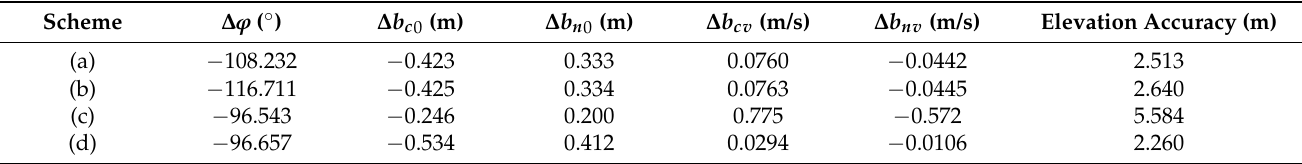
Table 8. Evaluation results of the interferometric calibration accuracies derived under 4 calibra- tion